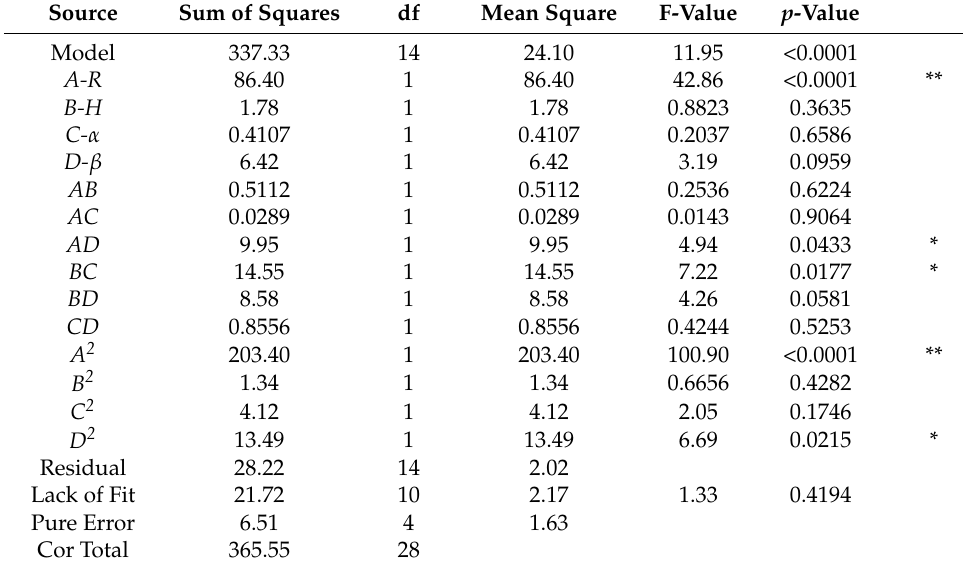
Table 9. ANOVA for Quadratic model of Rate of straw